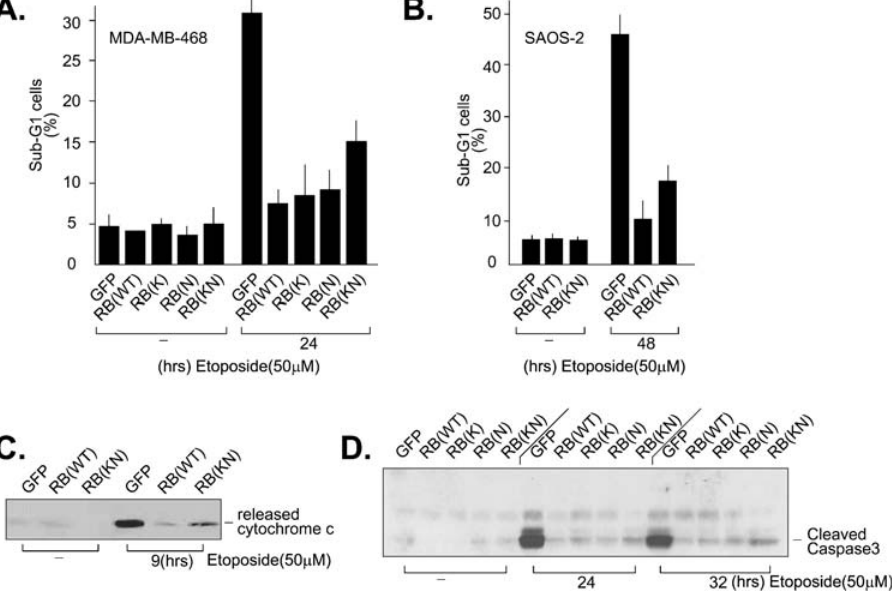
Figure 4. Death suppression activity of RB and mutants. A) Etoposide-induced DNA fragmentation in MDA-MB468 cells. Cells were infected with recombinant adenovirus expressing the indicated proteins. Infected cells were treated with 50 m M etoposide or vehicle control for 24 hr, fixed, stained with propidium iodide and DNA fragmentation (sub-G1 DNA content) measured by FACS. B) Etoposide-induced DNA fragmentation in SAOS- 2 cells. The same experiment as in (A) except the duration of drug treatment was for 48 hours. C) Etoposide-induced cytochrome c release. MDA- MB468 cells infected with the indicated recombinant adenovirus treated with 50 m M etoposide or vehicle control. At 9 hours after drug addition, cells were homogenized and the mitochondria were separated from the cytosolic fraction by centrifugation. The levels of cytochrome c in the post- mitochondrial supernatants were determined by immunoblotting. D) Etoposide-induced caspase 3 cleavage. MDA-MB468 cells infected with the indicated recombinant adenovirus were treated with 50 m M etoposide. Cells were harvested at the indicated time points and the levels of cleaved caspase-3 determined by immunoblotting with antibodies specific to the cleaved caspase-3.